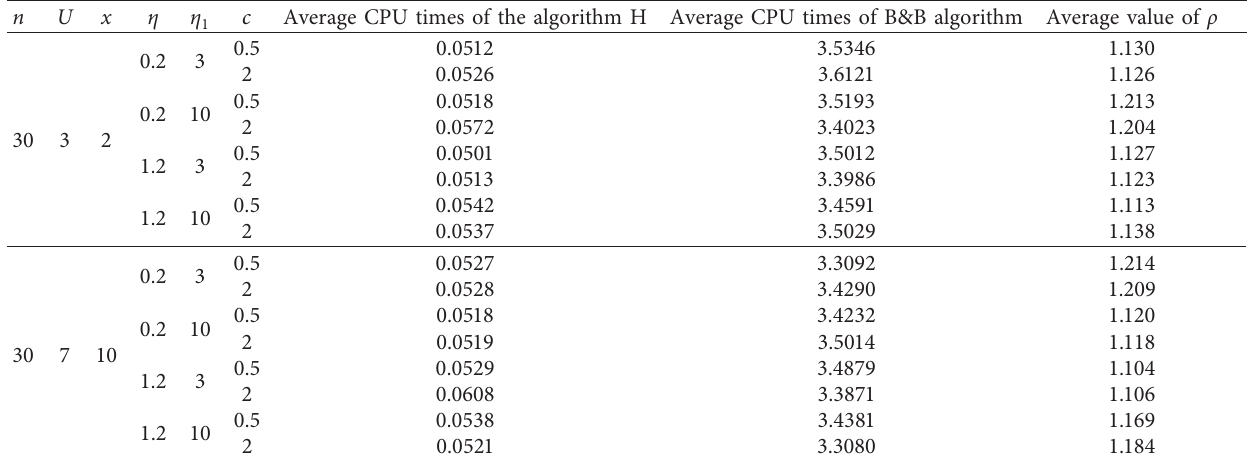
Table 5: The results of the algorithm H and branch-and-bound (B&B) algorithm for ( P 2). c n U x η η 1